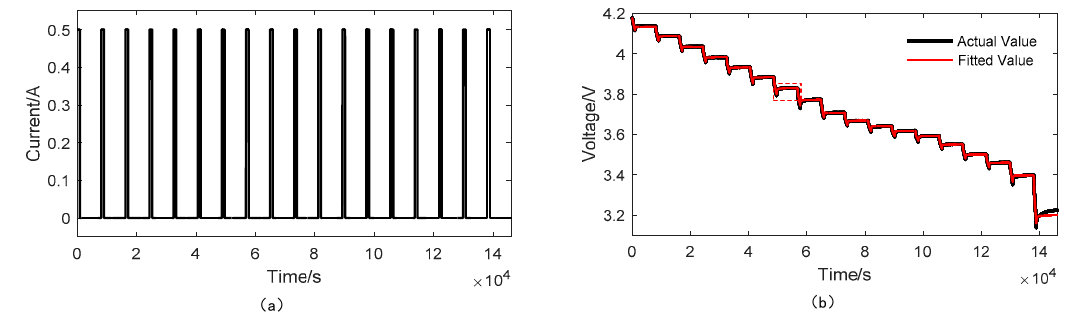
Figure 4. The 0.2 C pulse current discharge profile: ( a ) the current; ( b ) the voltage.